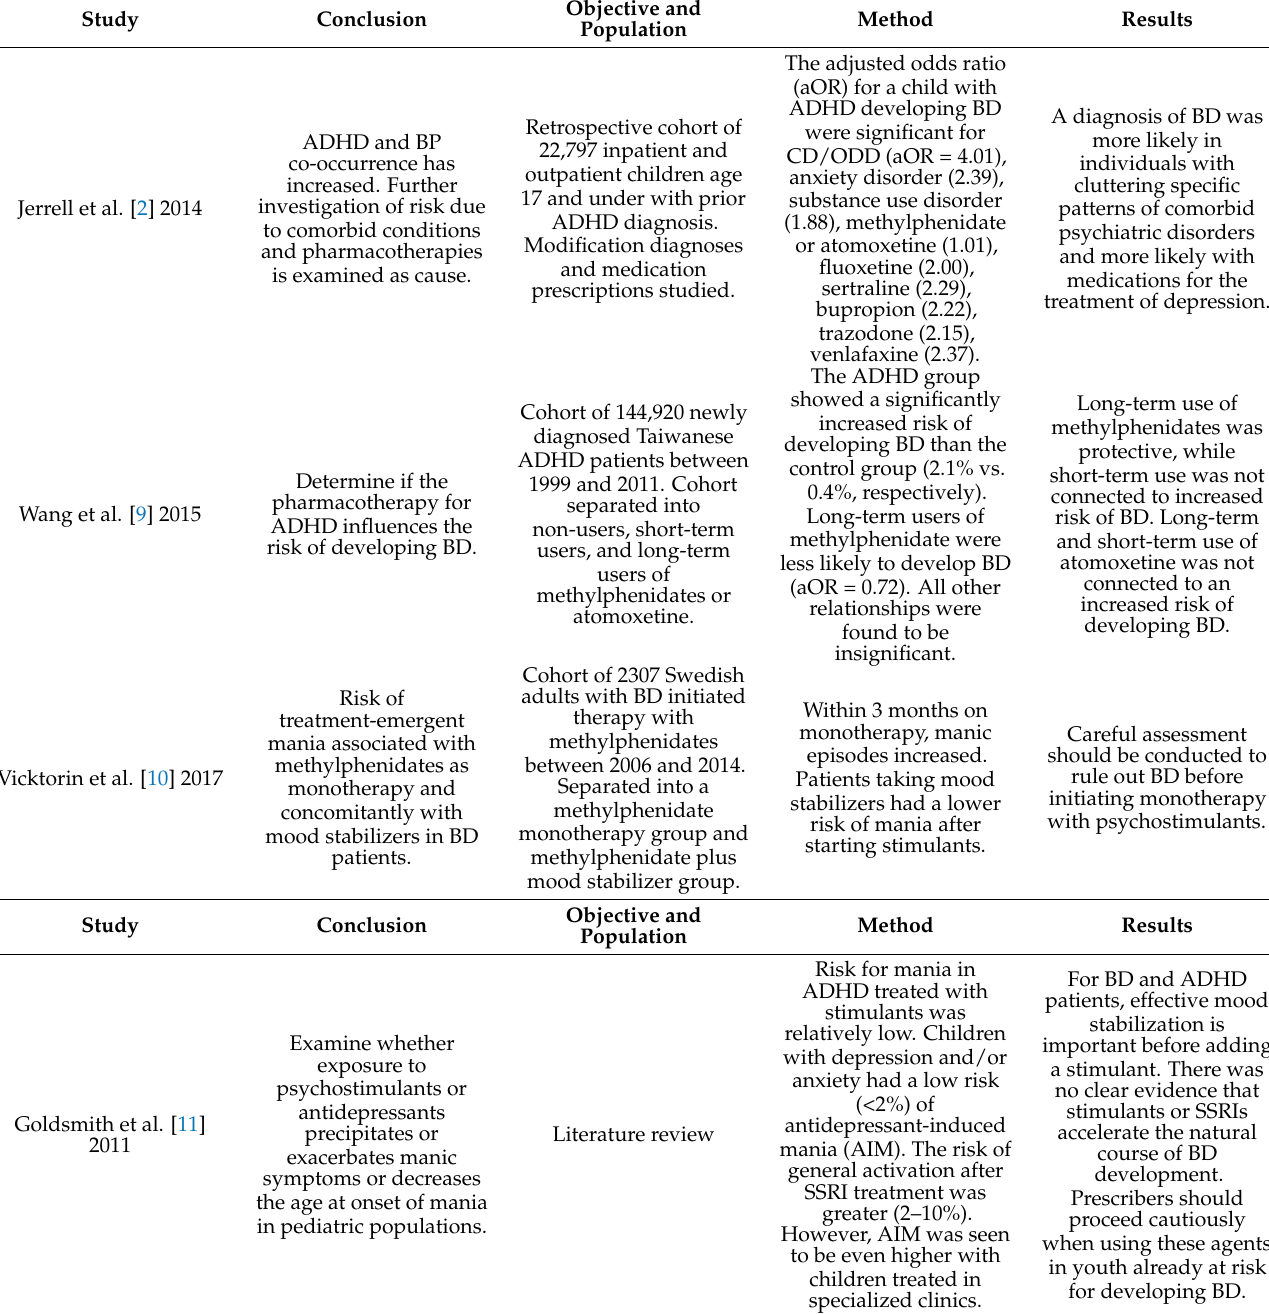
Table 1. Clinical trials examining the use of medications for ADHD and their likelihood of inducing manic-like behavior in the pediatric